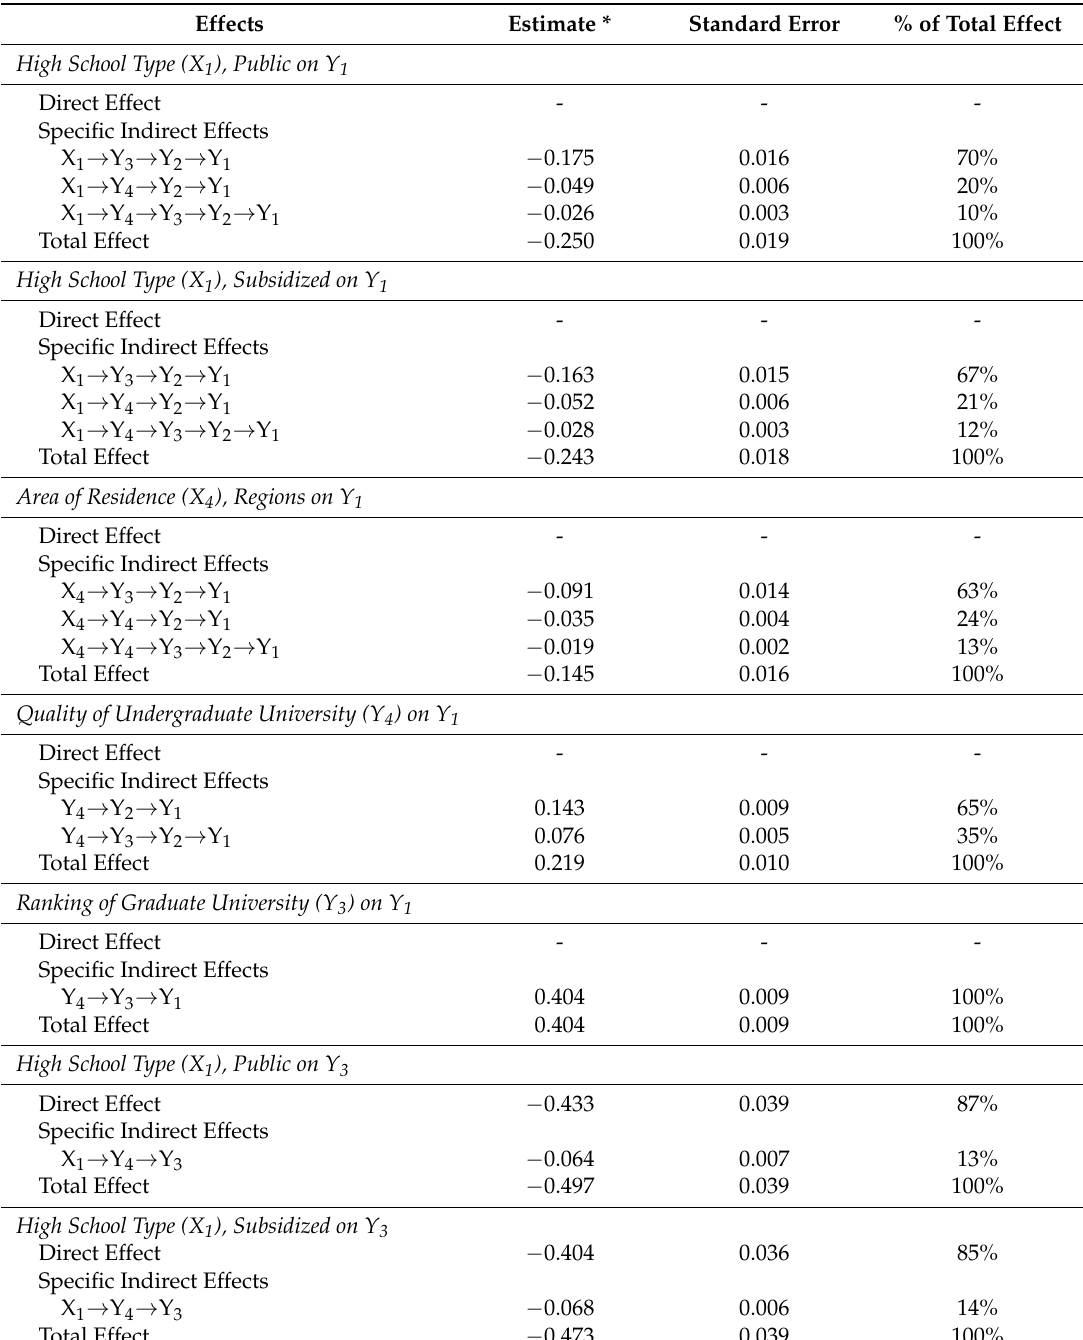
Table 4. Specific and total indirect